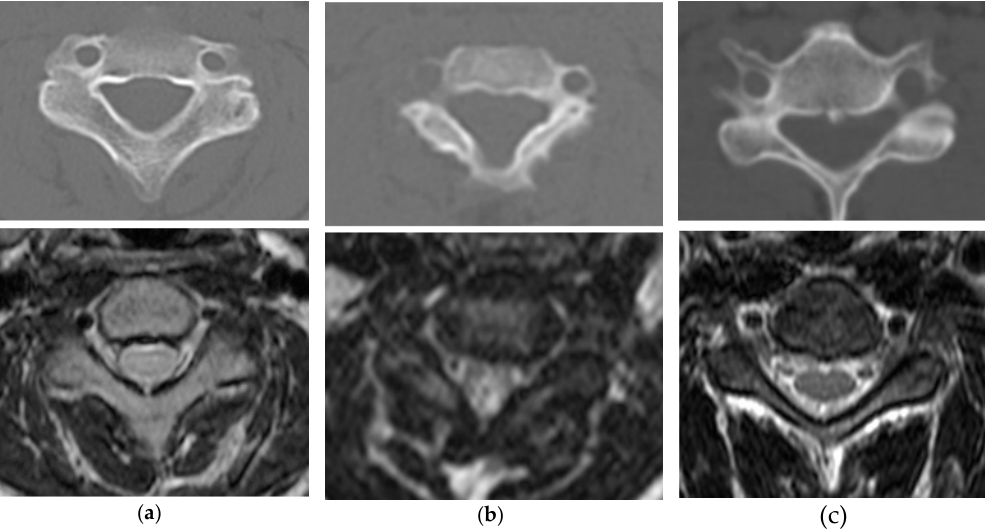
Figure 5. Shape of the spinal canal and spinal cord in MPS. 13-year-old boy with MPS II ( a ) and 3-year-old boy ( b ). The bony spinal canal is composed of thickened laminae and small vertebrae with less cerebral spinal fluid compared with a 48-year-old normal man ( c ). High-signal-intensity change in T2-weighed magnetic resonance image is seen ( b ). The upper column (computed tomographic images) and the lower column (T2-weighed magnetic resonance images) represent the same cervical level.